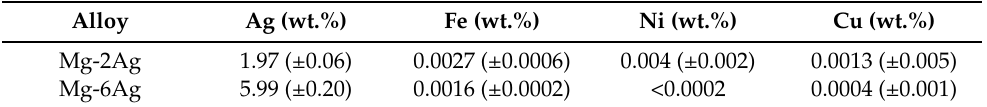
Table 1. Chemical compositions of all alloys analysed with atomic absorption spectroscopy for Ag and spark emission spectroscopy for Fe, Cu, and Ni, balance Mg, data from [8]. Alloy Ag